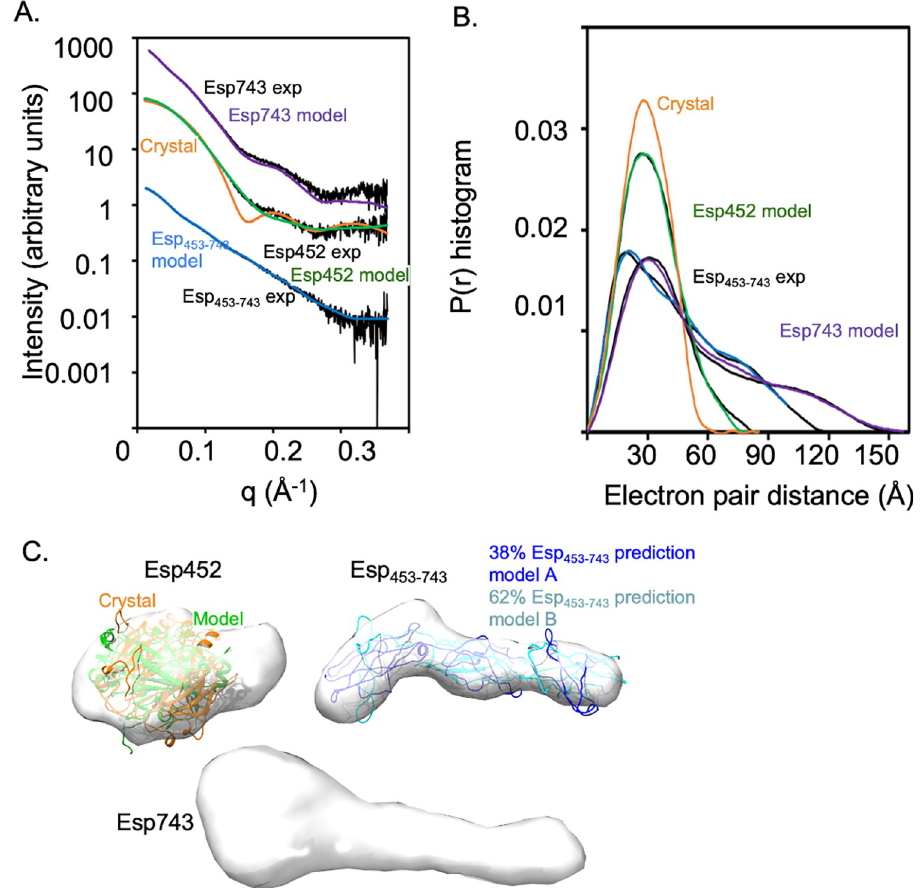
Fig 5. SAXS of Esp fragments. A. Experimental SAXS data (exp) in reciprocal space for Esp452, Esp 453-743 , and Esp743 overlaid with SAXS curves calculated for the crystal structure of Esp452 (orange) or models of Esp452, Esp 453- 743 , or Esp743 (green, blue, purple, respectively). B. Same as A, except in real space and only experimental data and SAXS curves predicted from models are shown. Curves were normalized for area under the curve. C. Shape reconstructions based on SAXS data of Esp452, Esp 453-743 , and Esp743 overlaid with Esp452 or Esp 453-743 models.